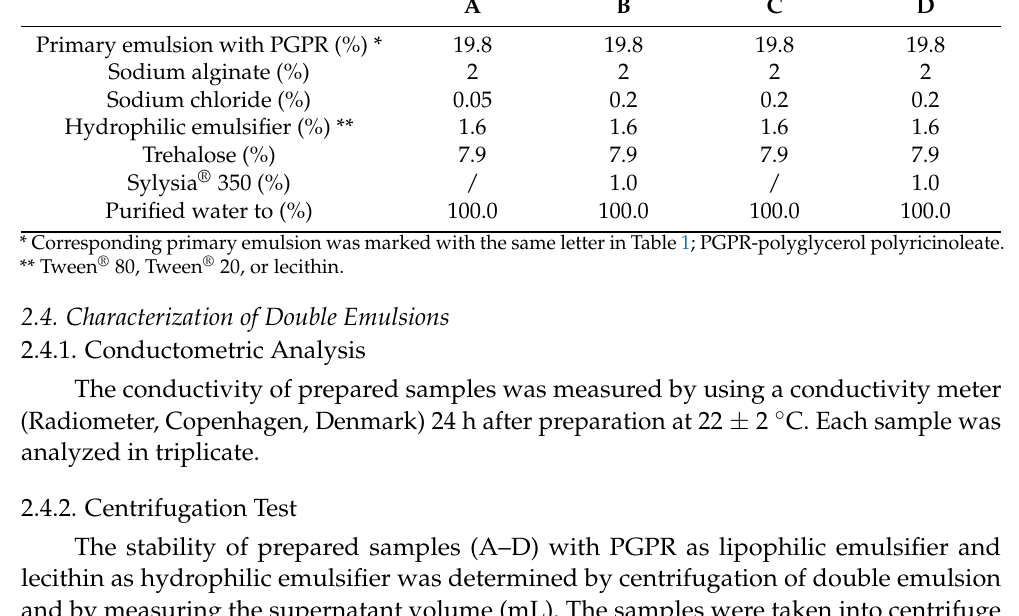
Table 2. A–D: Double (W/O/W) emulsion composition.